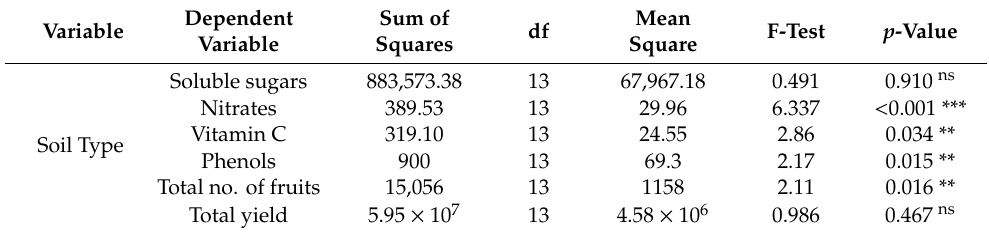
Figure 6. Nitrates concentrations in tomato grown in soils amended with amendments: Vermicompost (Vermi), no ‐ mulch soil mixed with biochar (NMBio), inorganic fertilizer (Inorganic), sewage sludge mixed with biochar (SSBio), vermicompost mixed with biochar (VermiBio), inorganic fertilizer mixed with biochar (InorganicBio), chicken manure mixed with biochar (CMBio), horse manure mixed with biochar (HMBio), chicken manure (CM), horse manure (HM), organic fertilizer mixed with biochar (OrganicBio), sewage sludge (SS), no ‐ mulch bare soil (NM), and organic fertilizer (Organic). Values accompanied by the same letter(s) are not significantly different ( p > 0.05). Table 2. Analysis of Variance (ANOVA) of the effect of soil amendments on soluble sugars, nitrates, vitamin C, phenols, total number of fruits, and total yield.